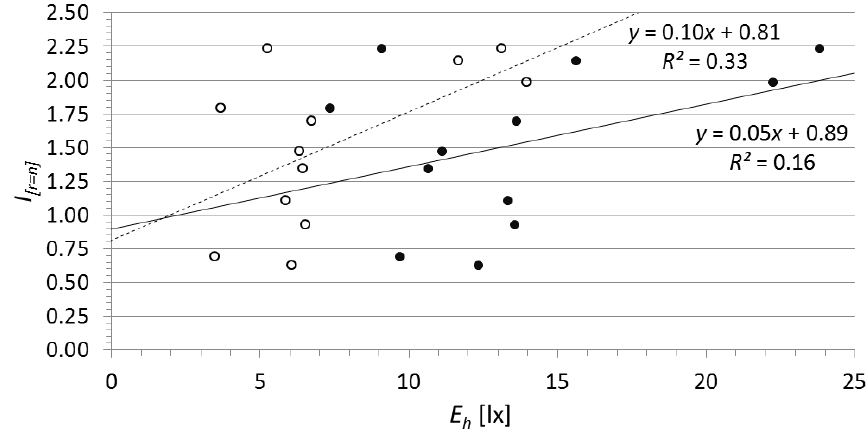
Figure 14. Scenario 1 (present status): correlations between I and E h,av (black circles and a continuous line for the regression) and between I and E h,min (white circles and a dotted line for the regression) on the sidewalks on the opposite side of the luminaires.